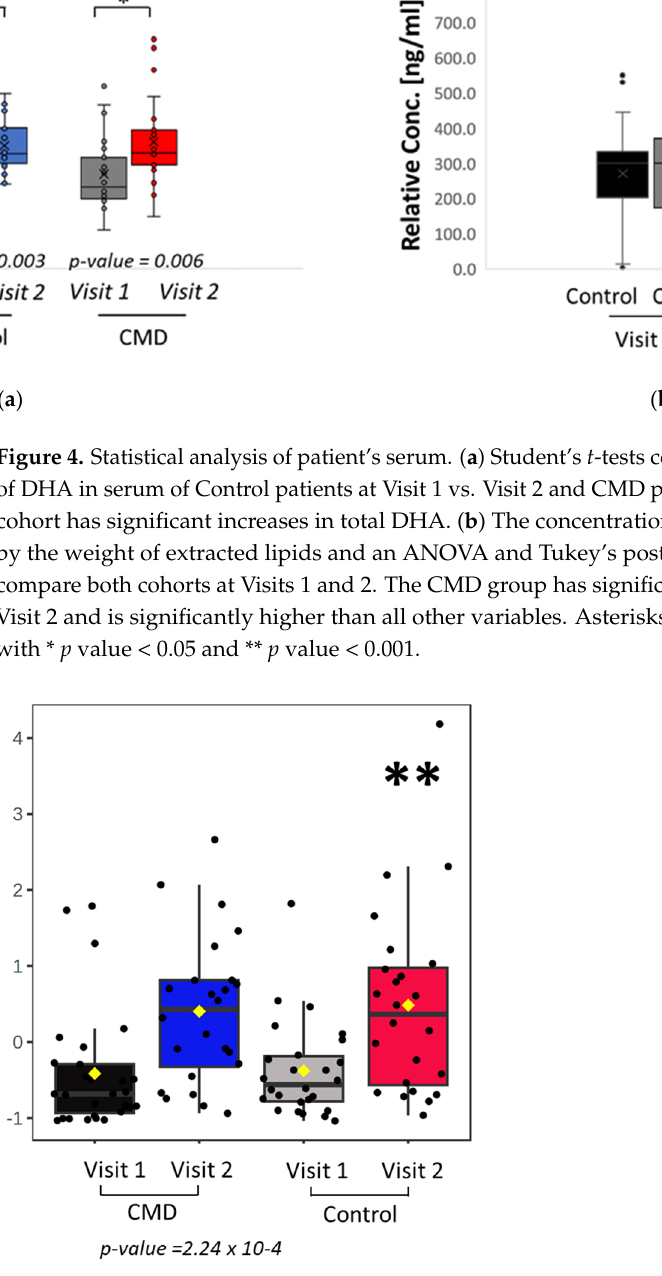
Figure 5. Dysregulation of 36:6 PC. There are significant increases in the distribution 36:6 PC in women with cardiovascular disease compared to the control group by ANOVA with Tukey’s post hoc analysis. The asterisks indicates statistical significance with ** p value < 0.001